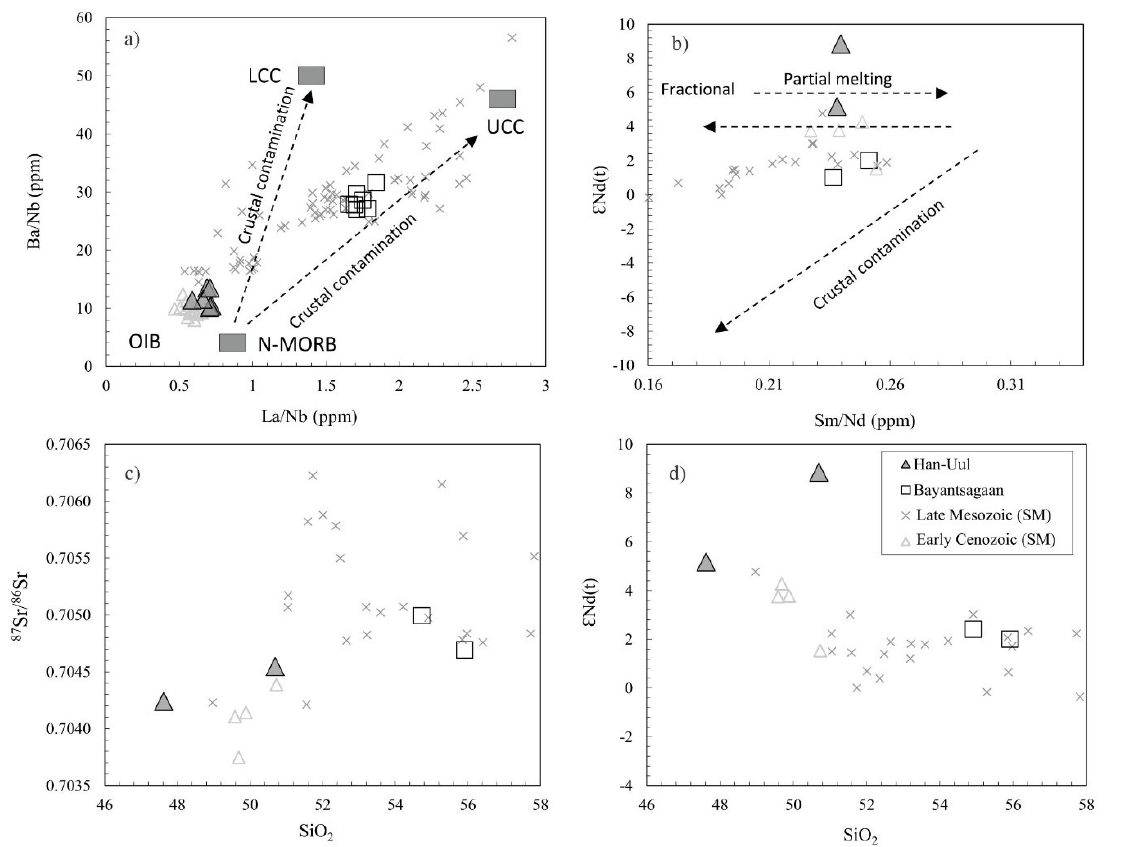
Fig. 8. Diagrams of La/Nb versus Ba/Nb (a), εNd(t) versus Sm/Nd (b), 87 Sr/ 86 Sr versus SiO SiO (d) for all analyzed basaltic samples from Bayantsagaan and Han-Uul. Previously published Sr-Nd isotopic 2 data (cross) taken from Barry et al. (2003), Yarmolyuk et al.